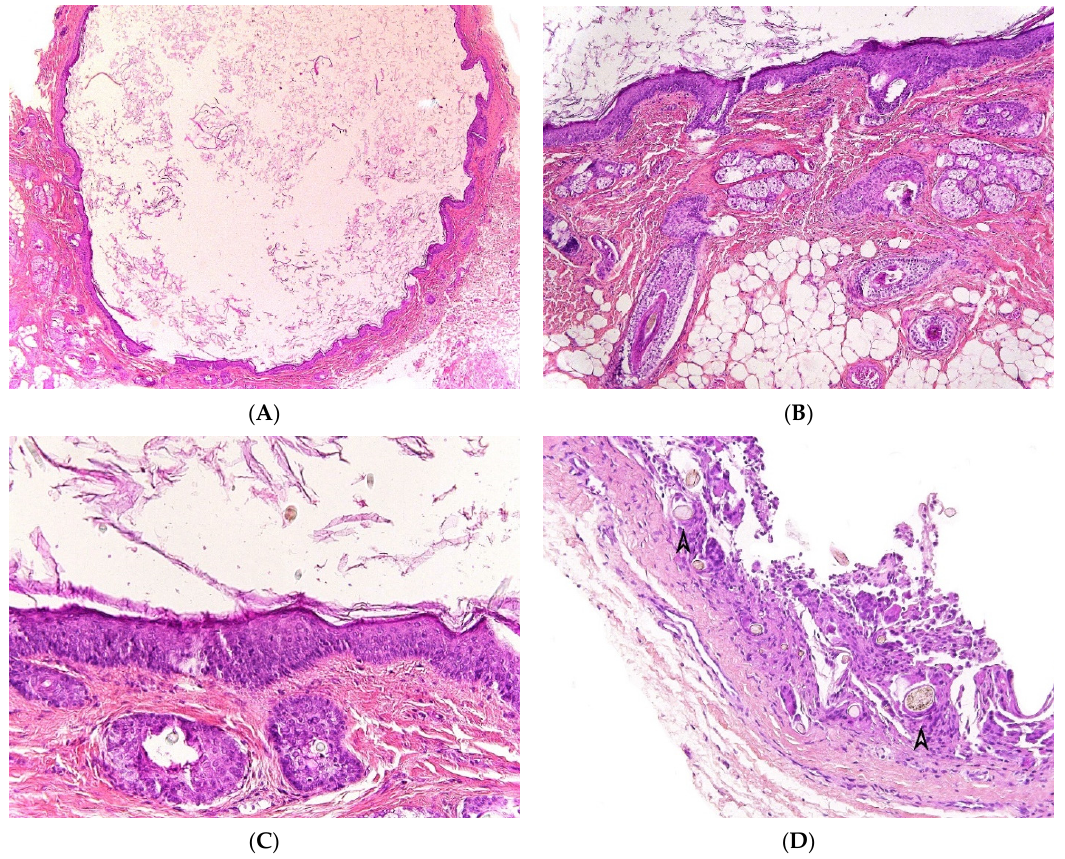
Figure 5. Dermoid cyst. ( A ) (H.E.S). The cyst is lined by keratinizing stratified squamous epithelium. ( B ) (H.E.S). The cyst is deeply located in the subcutis. Small hair follicles and sebaceous glands are attached to the epithelium. ( C ) (H.E.S). The lumen contains numerous vellus hair shafts and lamellated keratin, and the epithelium has a granular layer. ( D ), (H.E.S). Several vellus hairs (arrowheads) are observed within the granuloma.